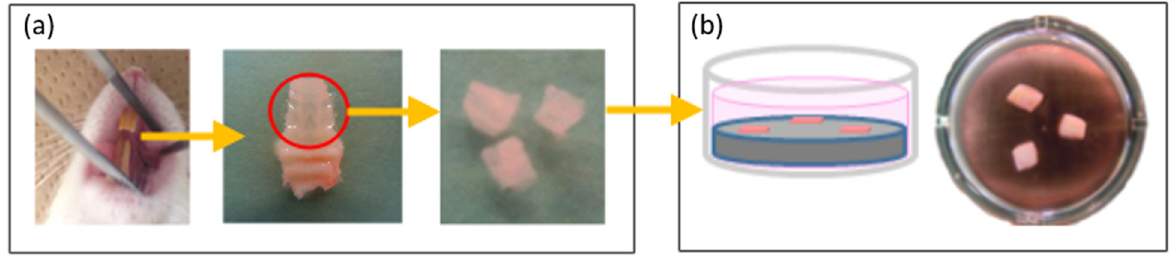
Figure 8. Experimental procedure for the setting of mucosa connective tissue. ( a ) Keratinized mucosa connective tissues derived from rat palate. Three to five sections (one section: 3 × 3 mm) were obtained from one palate. ( b ) Keratinized mucosa connective tissues setting on titanium surface in culture medium. Three sections were placed on each titanium disk and incubated for 24 h before the detachment test.